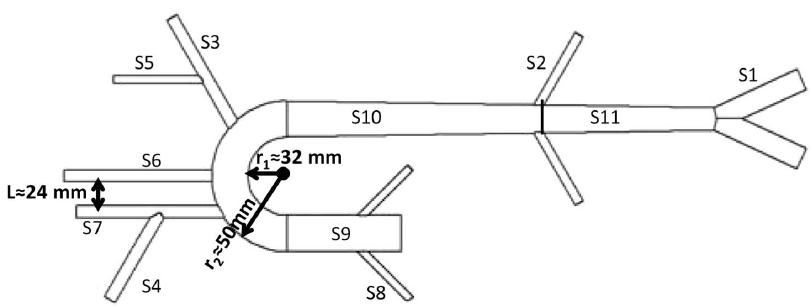
Figure 2. Schematic of the aortic mold. Dimensions are provided in Table 1.